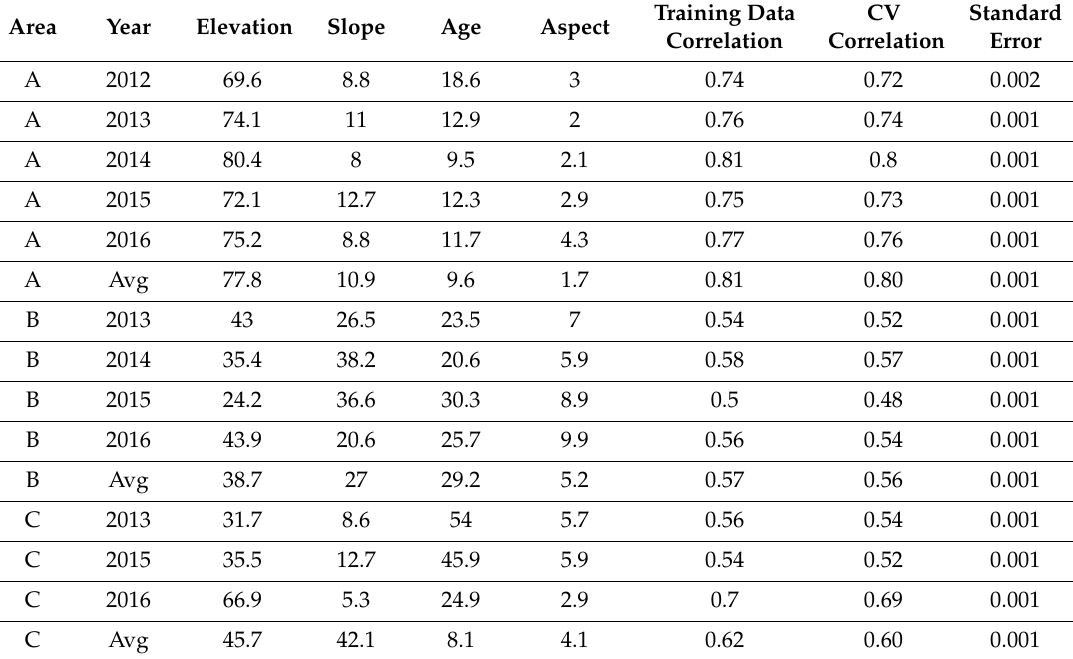
Table 5. Boosted regression tree predictor importance values, related to